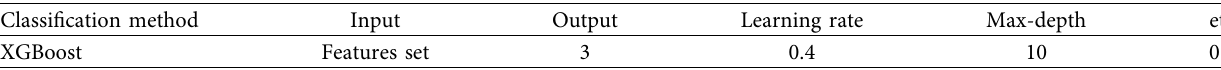
Figure 7: The relevant experimental scenarios and satellite distribution. (a) The overhead view of the four experimental routes. (b) Satellite distribution over a 20min collection. Table 1: Parameters for XGBoost. The learning rate and eta are hyperparameters in the training process.